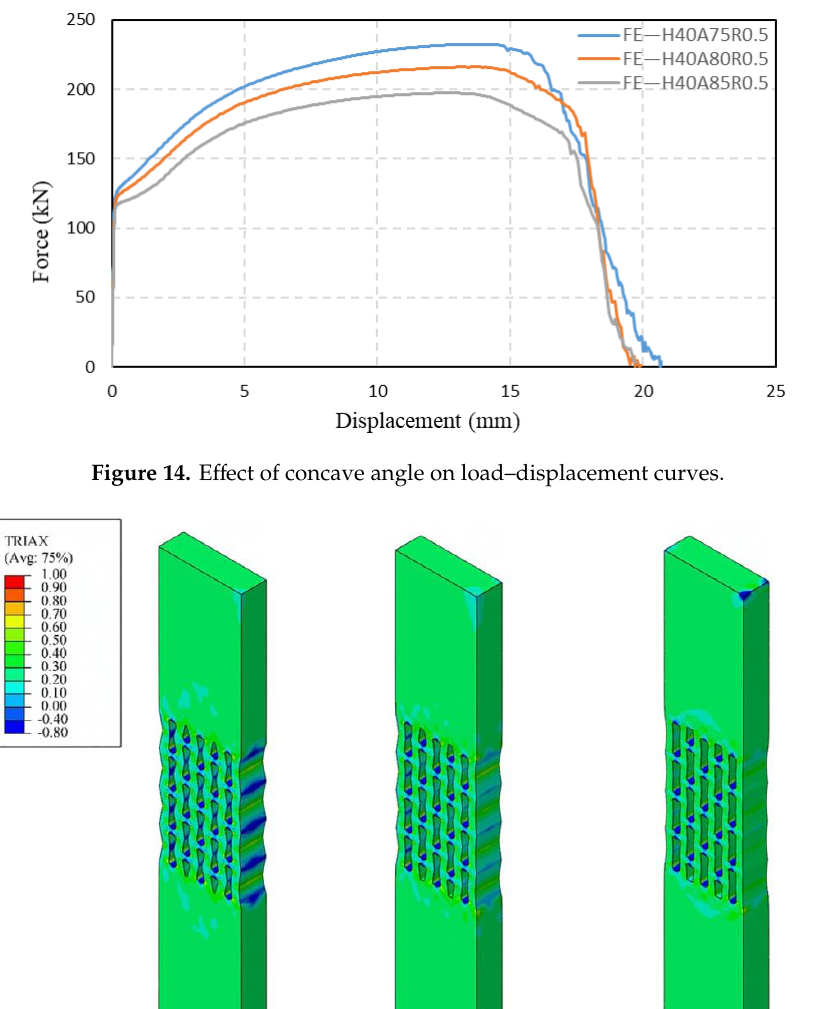
Figure 15. E ff ect of concave angle on stress triaxiality with ( a ) H40A75R0.5 ( b ) H40A80R0.5 and Figure 15. Effect of concave angle on stress triaxiality with (a) H40A75R0.5 (b) H40A80R0.5 and ( c )